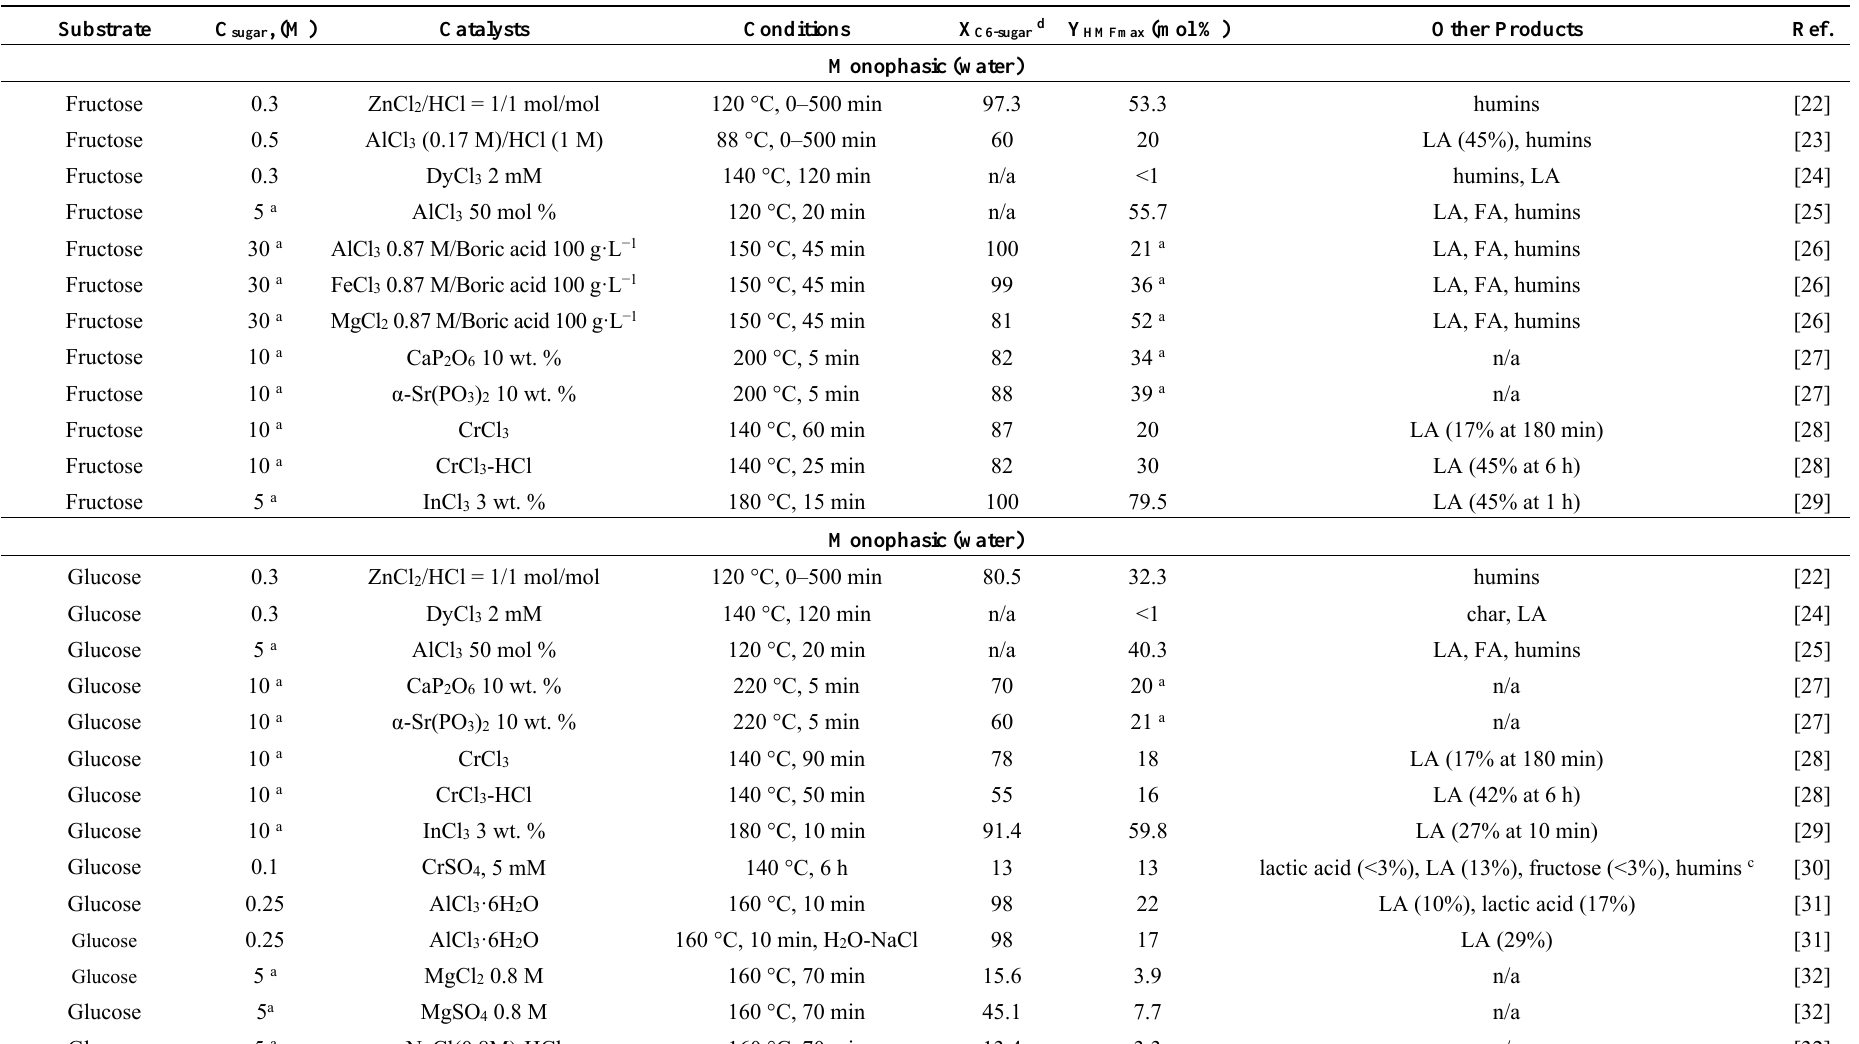
Table 1. Overview of reactions of D -fructose and D -glucose to HMF in the presence of soluble metal salts in